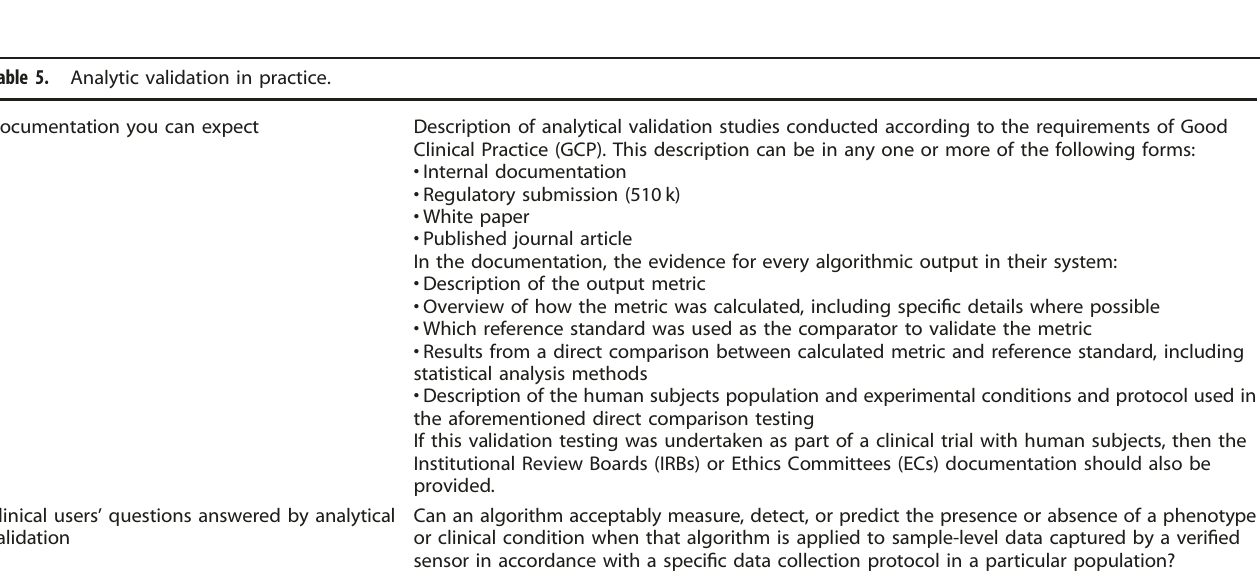
Table 5. Analytic validation in